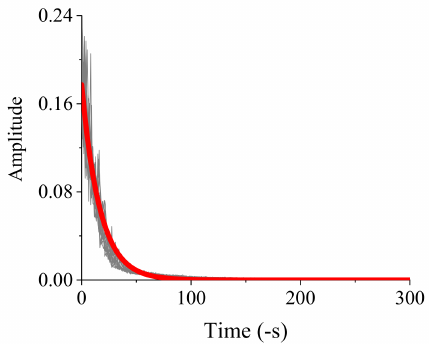
Figure 12. Negative-time spectrum of the D F ( f ) / W ( U r ) . Obviously, all the gray lines have similar shapes. An exponent function N ( τ ) in Equation (6) is used to describe the negative-time spectrum of D F ( f ) / W ( U r ) , and C f is the amplitude parameter controlling the power of D F ( f ) / W ( U r ) . The fitted N ( τ ) is plotted in a bold red solid line in Figure